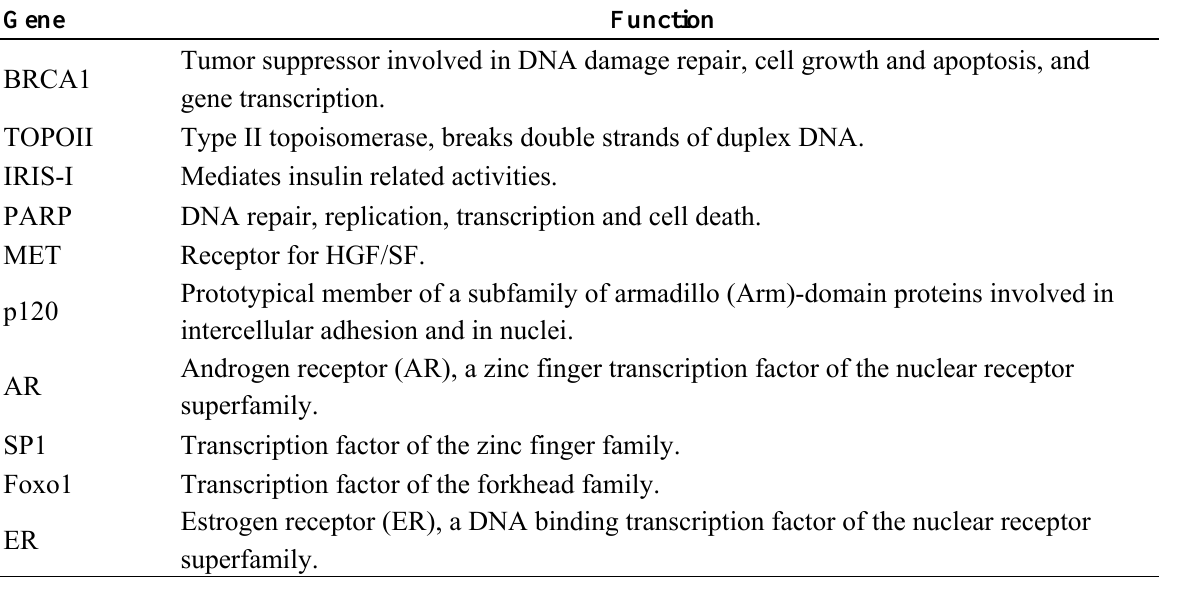
Table 4. Function of gene products identified in MCF7 and C4.12.5 cells by Western analyses. Gene Function